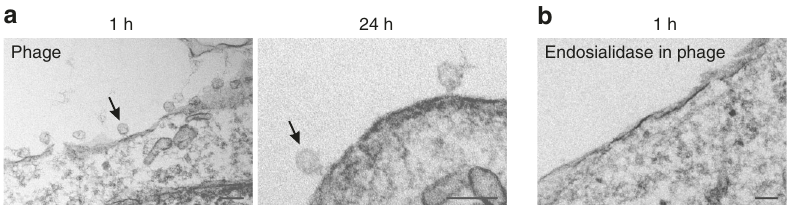
Fig. 7 Ultrastructural analysis of cells with phages. a , b Transmission electron micrographs of thin sections of kSK-N-SH cells incubated with phages ( a ) or endosialidase-containing control phages ( b ) at 37 °C for the times indicated. The arrows indicate examples of surface-bound phage particles. The scale